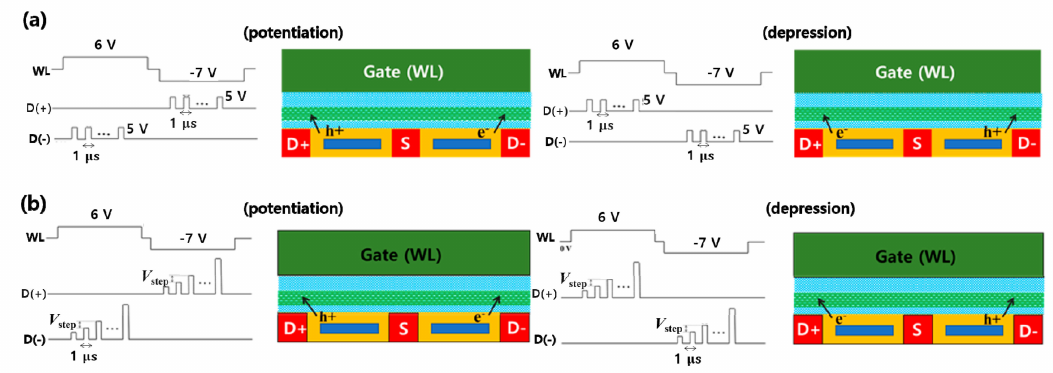
Figure 5. Programming schemes for synaptic weight (conductance). ( a ) Successive-pulse programming scheme; ( b ) Incremental-step-pulse programming scheme.